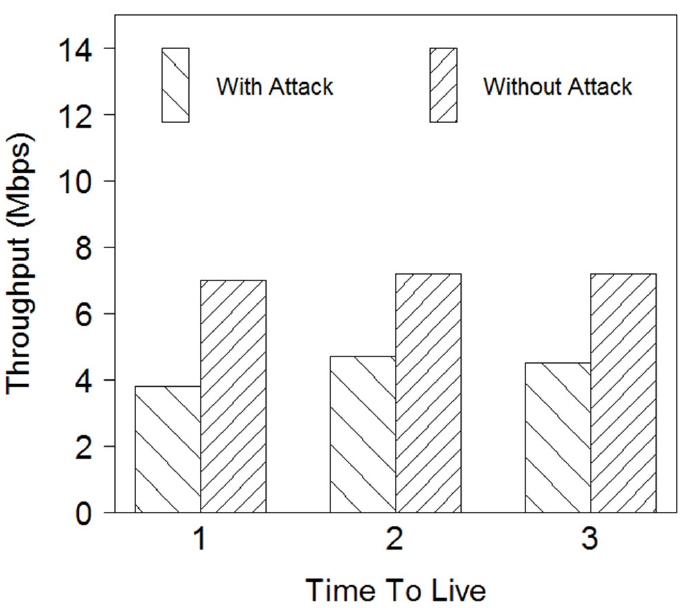
Figure 11. Time to live vs. throughput.